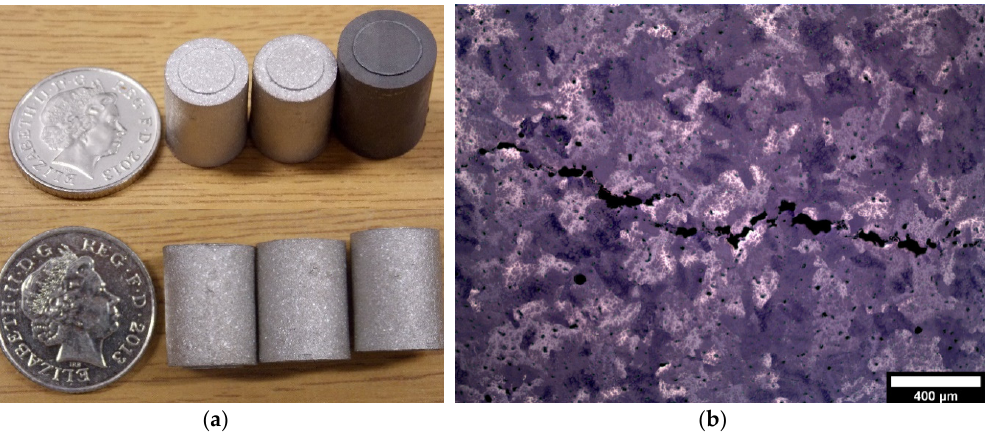
Figure 8. ( a ) Side and top view of sintered and green samples; ( b ) lateral view of a crack. It was also noted that the majority of the samples had small crater-like defects at the surface and some blistering. These craters are believed to be formed due to the thermal decomposition and diffusion of the high viscosity part of the binder from the inside of the sample through the surface during the initial stages of the sintering cycle, leaving a small volcano-like blister with crater-like features. The relative densities and volume shrinkages of the samples after sintering are shown in Figure 9.